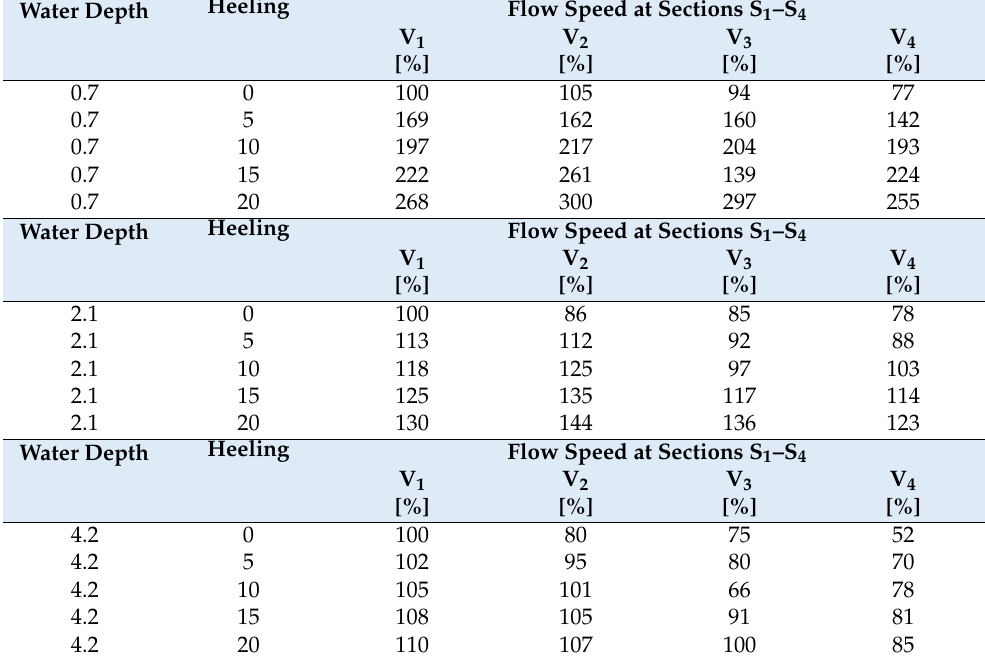
Table A1. Comparison of maximum flow speeds at sections S 1 –S 4 at different initial water depths in the tank and heeling angles of the test rig. For each water depth, the V 1 sensor at zero heeling angle has the nominal value of